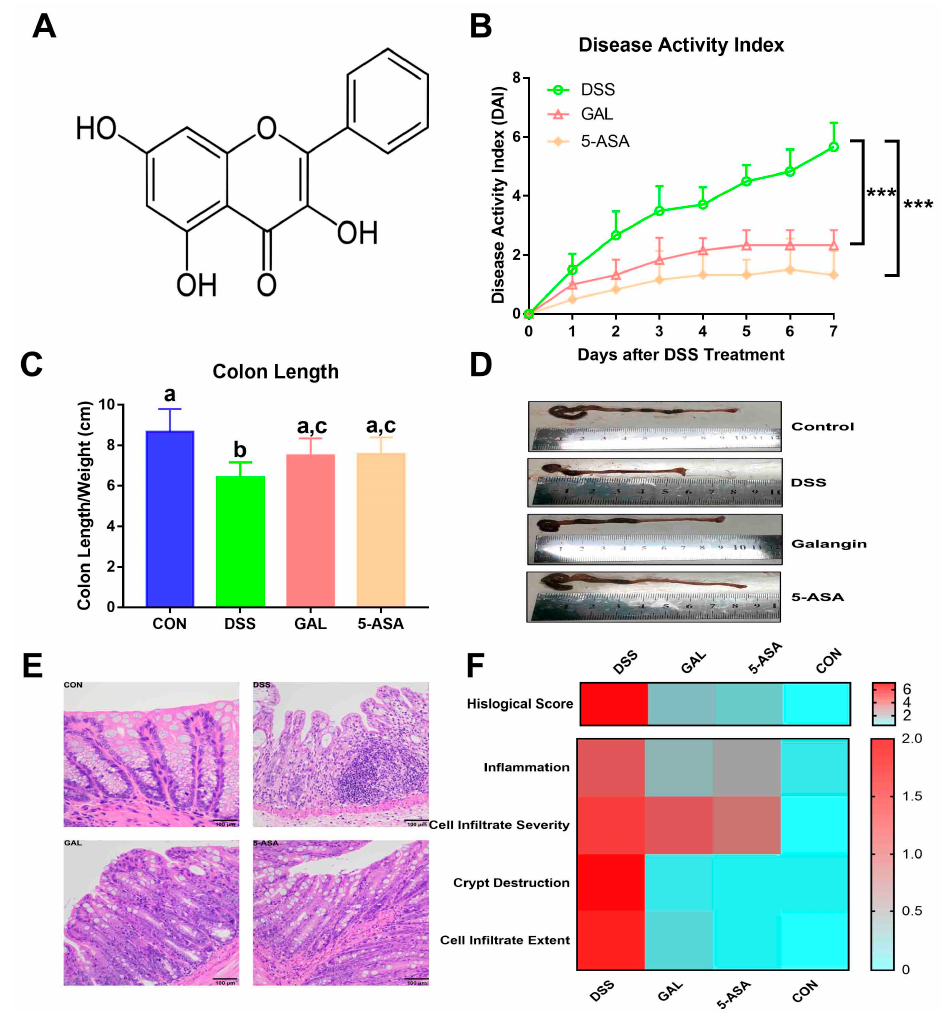
Figure 1. Galangin (GAL) ameliorated acute colitis symptoms induced by dextran sulphate sodium (DSS) in mice. Galangin (15mg/kg, p.o .) were pre-administrated to the mice for 7 days and until the end of the study. DSS (M.W. 36–50 kDa, 3% in tap water) was applied to the animals for 1 week. ( A )